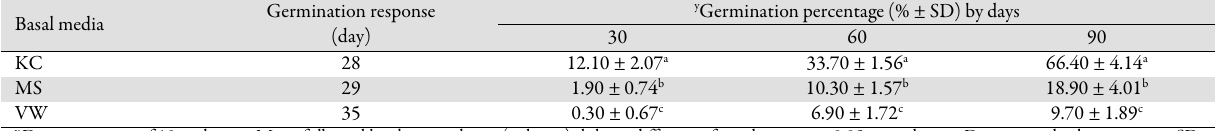
Table 1. Effect of basal media on germination of Vanda helvola seeds after 30, 60 and 90 days of culture Basal media